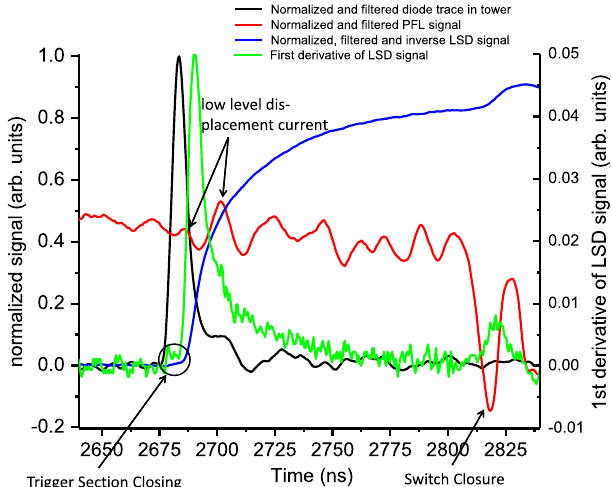
FIG. 6. Plot of the laser photodiode trace (black), the PFL signal voltage (red), and the on-shot LSD signal (blue). All signals have been normalized and are time corrected as ex- plained in the text. The first derivative of the LSD signal (green) is shown as well. Note: The trigger (7.7 ns) and cascade (130 ns) runtimes shown in this figure are unusually long. This was done in order to see details in the LSD signal more